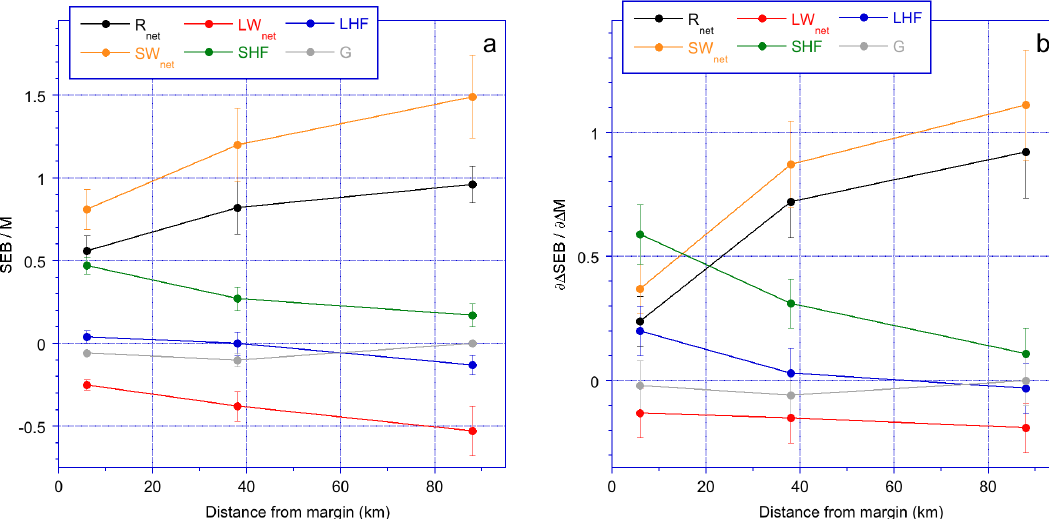
Fig. 11. Variation with distance from ice margin of (a) : fraction of total melt energy provided by SEB components (error bar indicate standard deviation from year to year) and (b) : regression slope of cumulative monthly SEB energy components with cumulative monthly melt (error bar represents standard deviation from regression performed on subsets of the